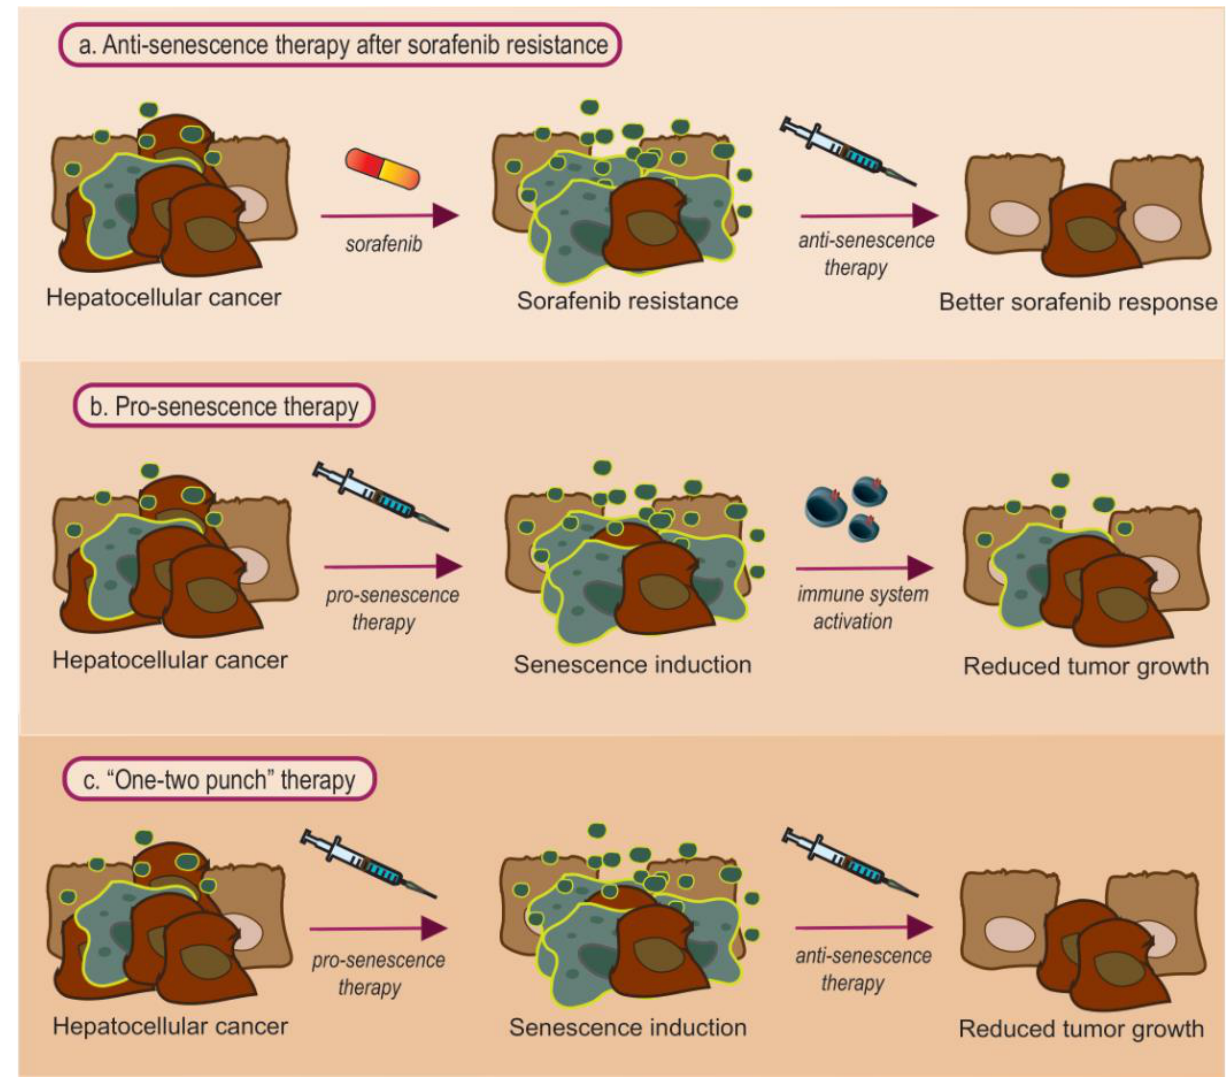
Figure 2. Proposed senotherapeutic strategies: ( a ) anti-senescent agents may be especially useful against sorafenib resistance, a condition associated with senescent cell accumulation. Sorafenib induces the formation of senescent cells, in which it is no longer effective. Thus, a combination of sorafenib with an anti-senescent agent may result in better sorafenib response. ( b ) Pro-senescent agents may have the potential to halt tumor growth via inducing senescence. Thus, malignant cells enter proliferative arrest, and provided that the immune system works, most senescent cells are cleared in an immune-mediated fashion. ( c ) The combined “one-two punch” approach. In this treatment strategy, one starts with a pro-senescence agent, to promote senescence of malignant hepatocytes. As senescent cells may start to accumulate, an anti-senescent agent is administered in the next step, in order to enhance senescent cell clearance. Normal hepatocytes are presented in pale brown, malignant ones in dark brown, whereas senescent ones are presented in light blue with yellow outline.